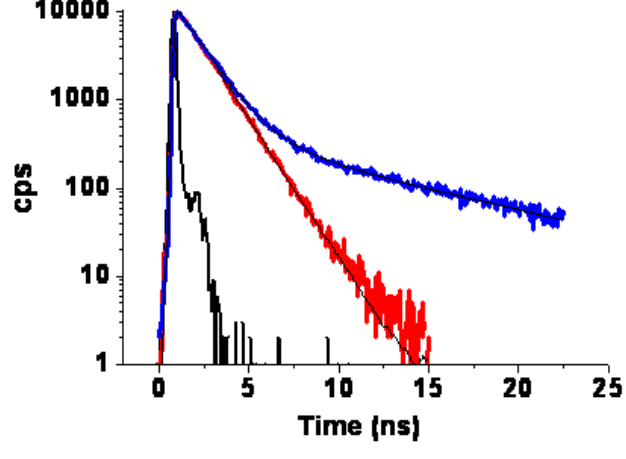
Figure 7. Fluorescence decay of 4 in THF solution for two emission wavelengths: Red 607 nm; Blue 657 nm. Excitation at 405 nm.